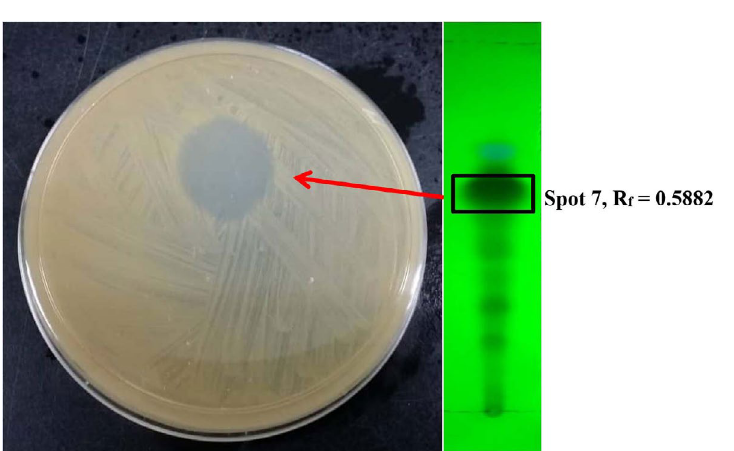
Fig. 2. Anti-MRSA activity of spot 7 of crude extract prepared from YES culture containing host plant extract on TLC